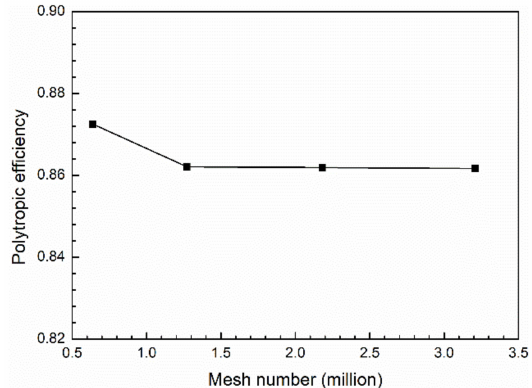
Figure 3. Grid independence verification of the calculation.